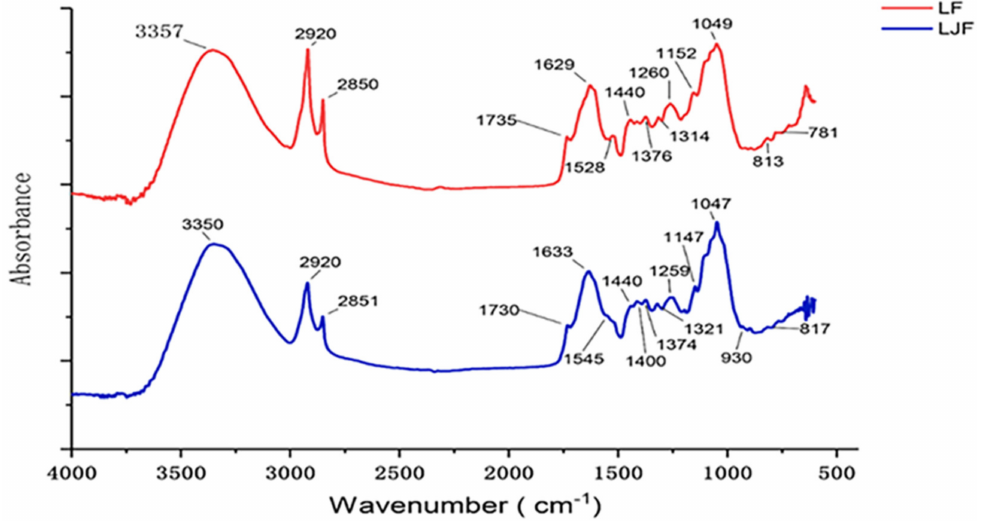
Figure 1. ATR-FTIR spectra of representive LJF and